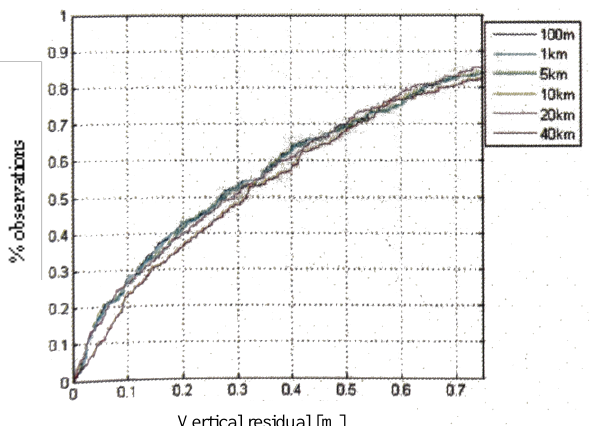
Figure 8. Vertical residuals vs % – u-blox 5T – 5 minutes